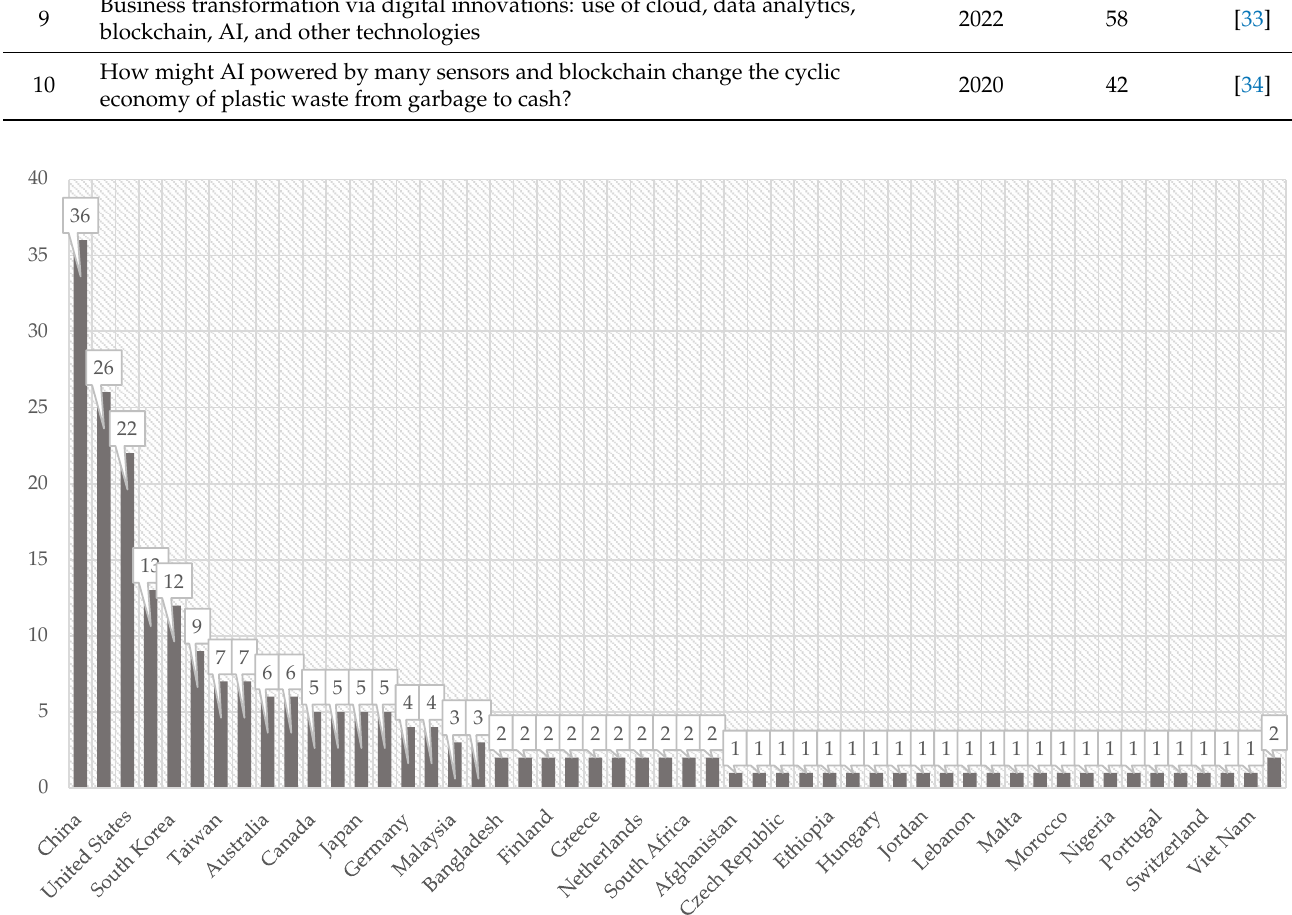
Figure 6. Distribution of authors by country. Table 1. Top 10 publications between 2012 and 2022 in terms of citations. The high citation rate indicates that the combination of AI and blockchains is significant and progressing.